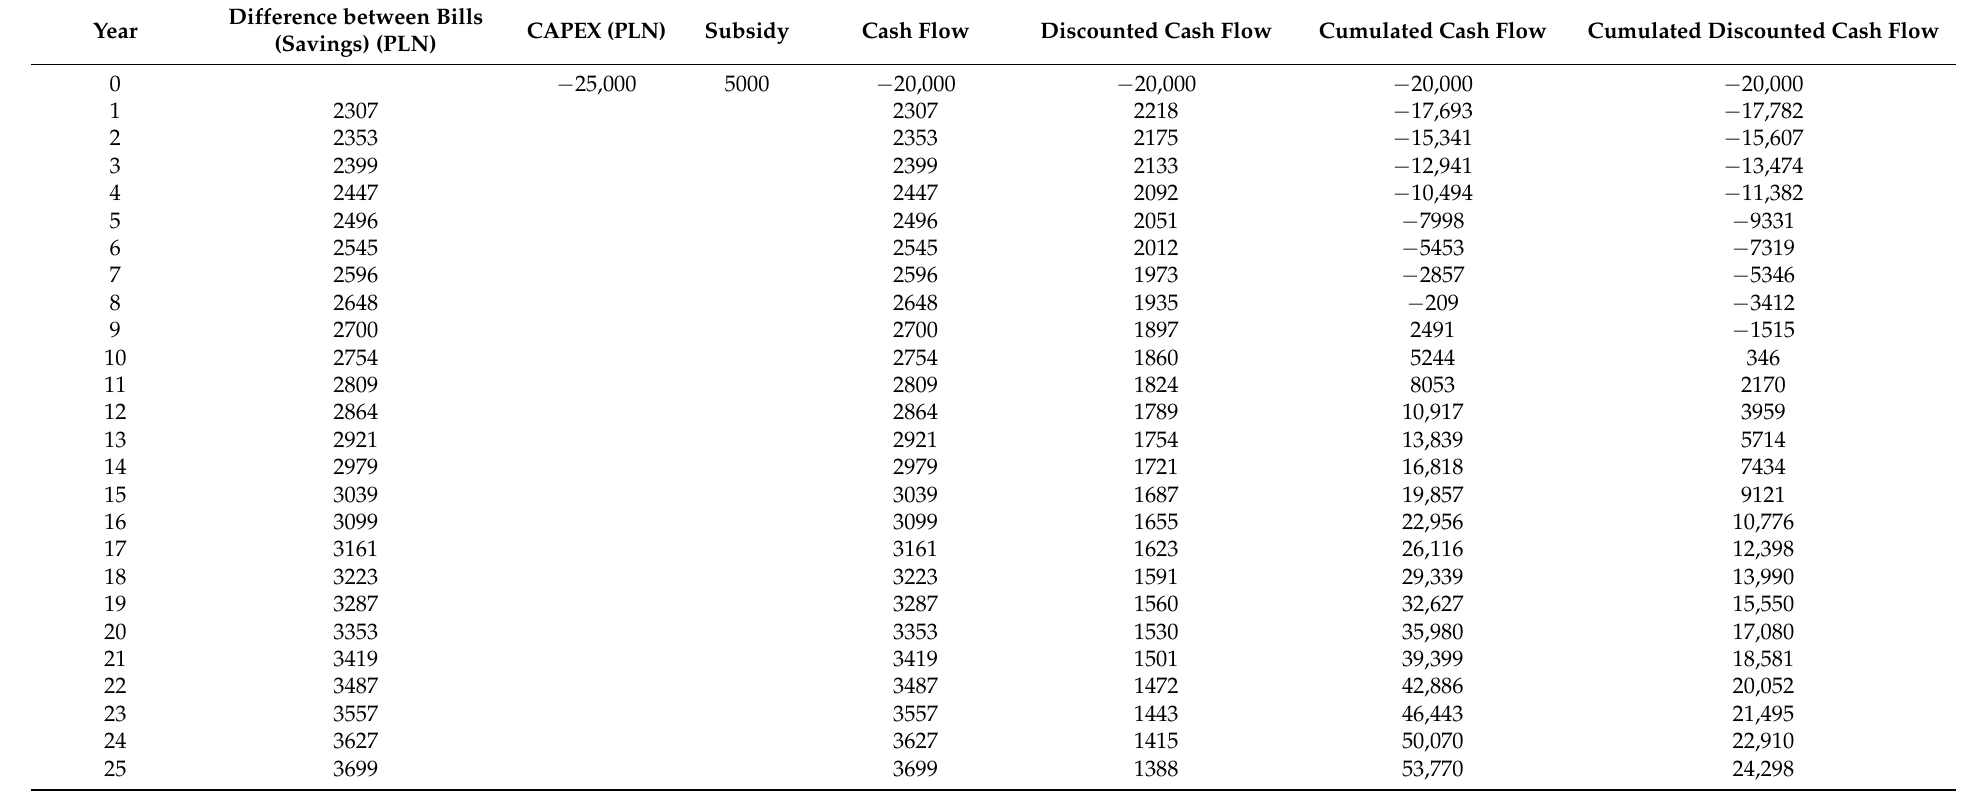
Table A4. Cash flows for net-billing